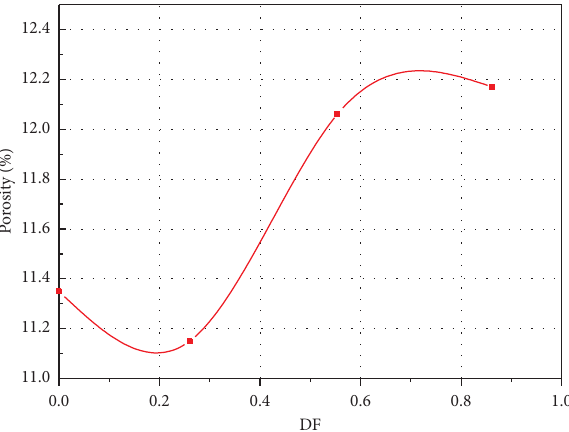
Figure 18: DF versus porosity of the typical